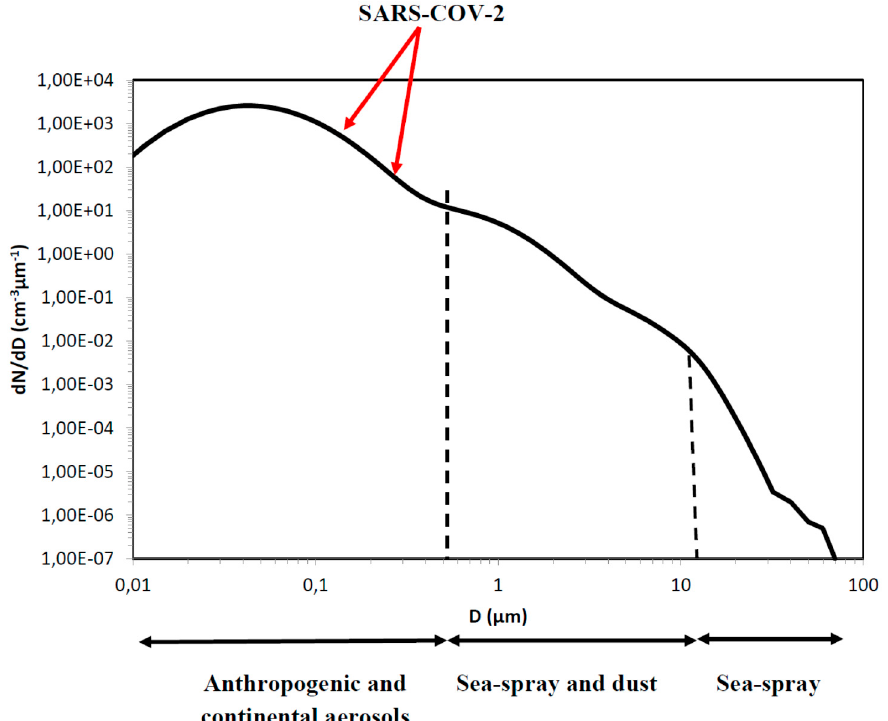
Figure 9. An example of aerosol size distributions typical of the coastal zone issued from measurements conducted on the island of Porquerolles by Van Eijk et al. (2011). As shown, the aerosol concentration dN/dr can be fitted by the sum of five lognormal functions centered on radii of 0.01, 0.03, 0.24, 2 and 10 μ m. (the black line). The dashed lines indicate the size intervals dealing with the different aerosol sources found in the coastal zone. The arrows indicate the expected size of SARS ‐ CoV2 (around 100 nm).